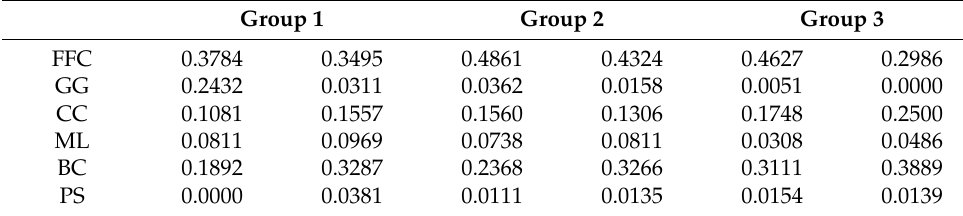
Table 5. Credit values ratios.